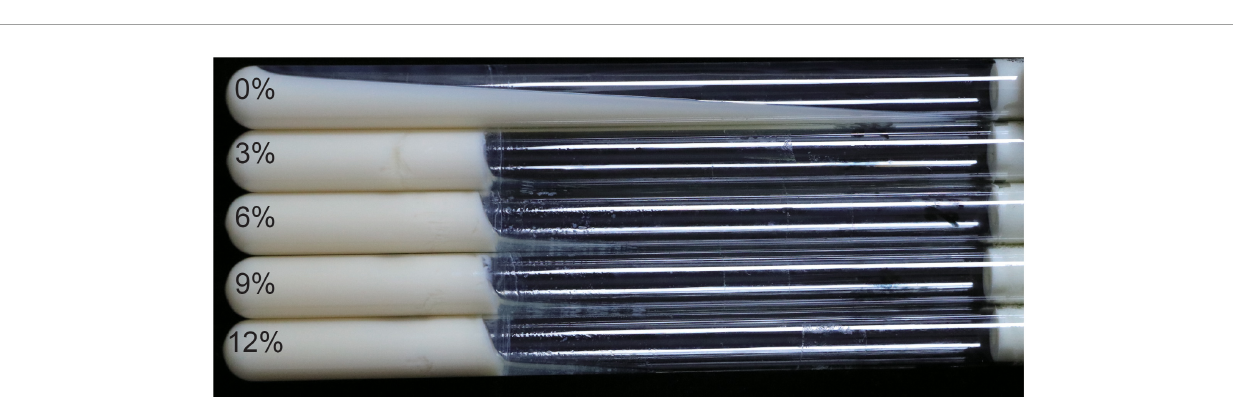
FIGURE11 Effect of Leu. mesenteroides RSG7 dextran on the solidification of sucrose-supplemented skim milk. A total of 0, 3, 6, 9, and 12% represent the concentrations of